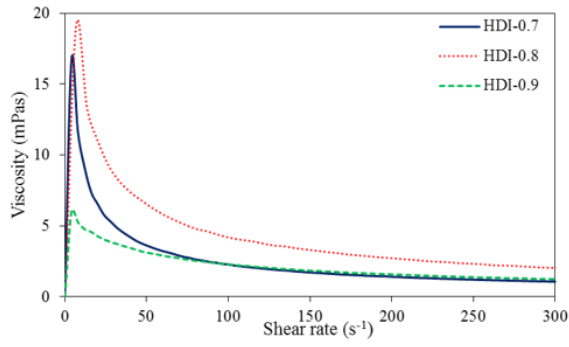
Figure 10. Rheological behaviors of WUOs synthesized using HDI and different NCO/OH mole ratios.